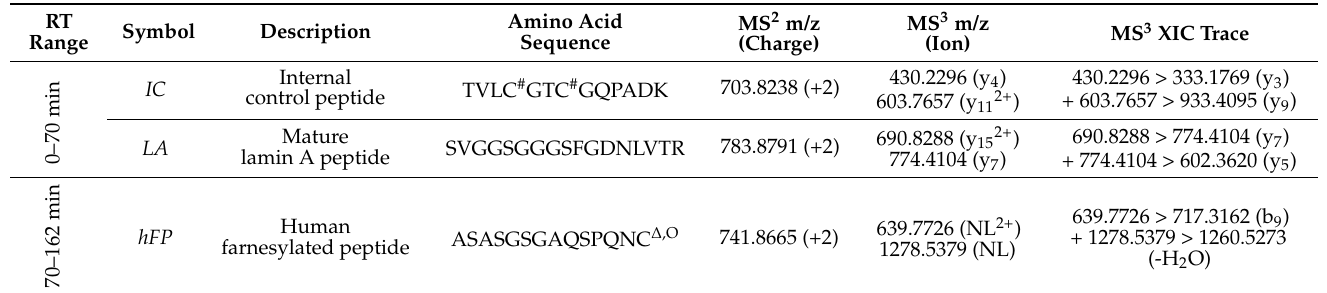
Table 2. Precursor and fragment ions included in the PRM assay aimed at the relative quantitation of lamin A and progerin in human samples.